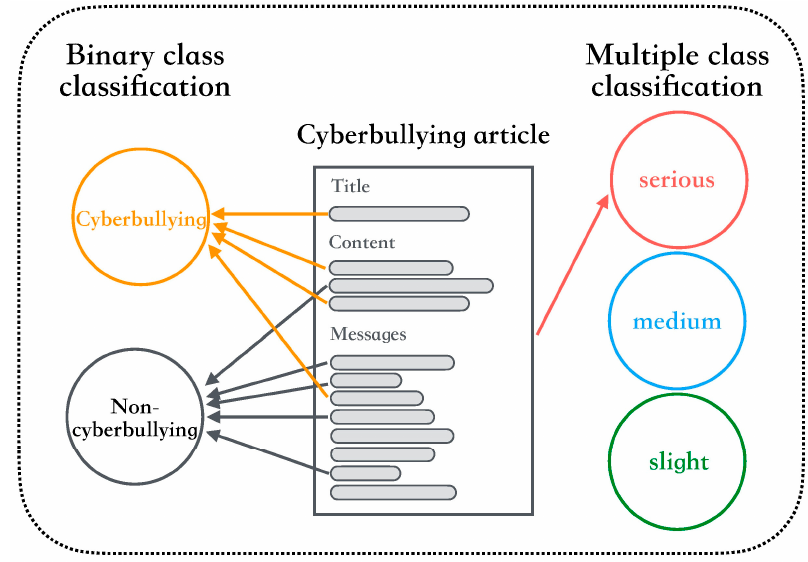
Figure 1. Cyberbullying severity classification task.